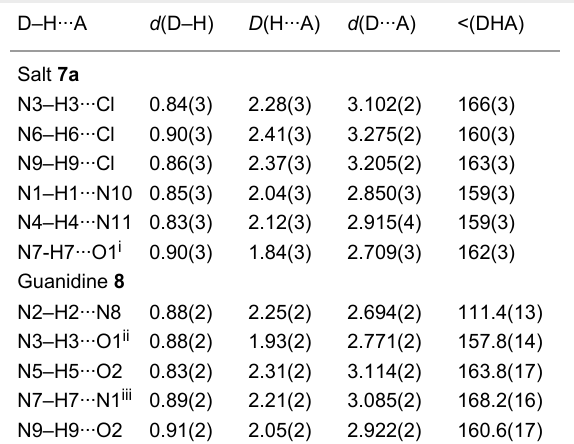
Table 1: Hydrogen bonds in the solid-state structures of 7a and 8 (Å and °).